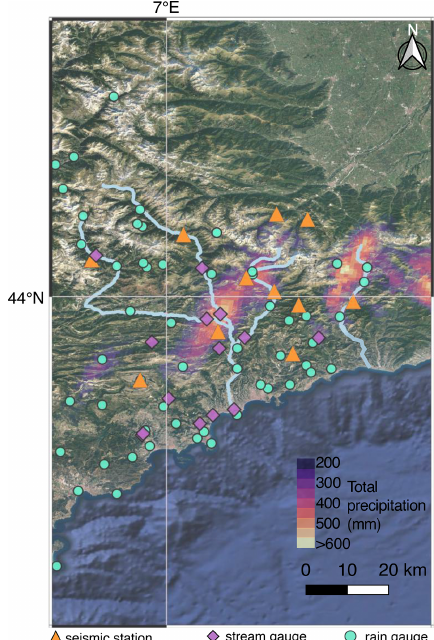
Figure B1. The location of rain and stream gauges and seismic stations in southeastern France. Background map source: © Google Maps 2021.